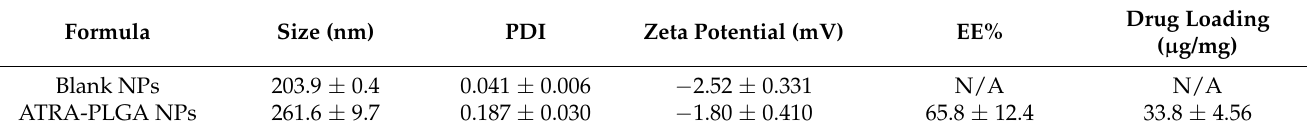
Table 1. Physicochemical properties, encapsulation efficiency and drug loading of ATRA-PLGA NPs; nanoparticles were formulated using the nanoprecipitation method (1:20 w / w drug:polymer). All loaded formulations were purified using centrifugation, disrupted in 1:100 ( v / v ) NPs/MeOH. UV-Vis was used to quantify the drug content at 348 nm. The average hydrodynamic diameter, PDI and zeta potential of NPs were measured by a Malvern Nanosizer ZS-90. Data reported as mean ± SD (n =